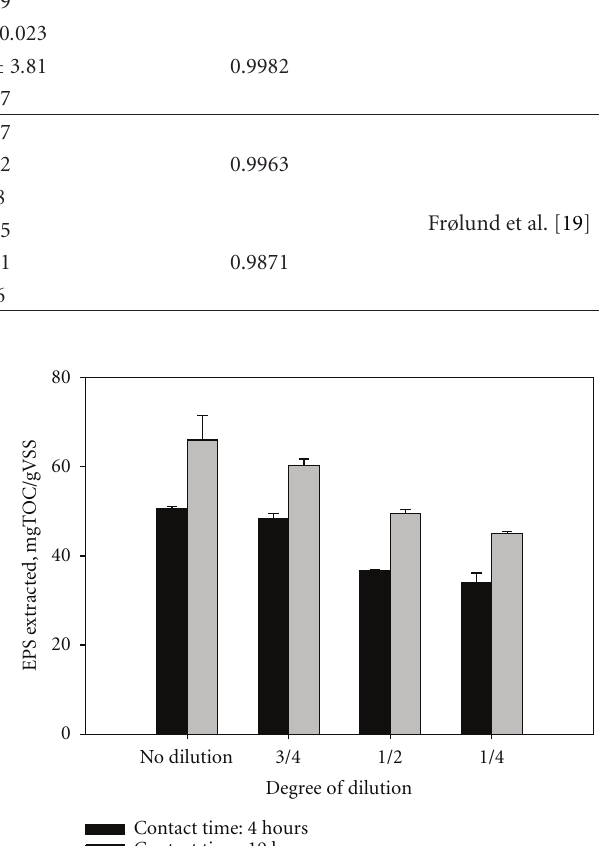
Figure 3: E ff ect of sample dilution on the EPS extraction (resin dose = 70 g/gVSS; stirring intensity = 600